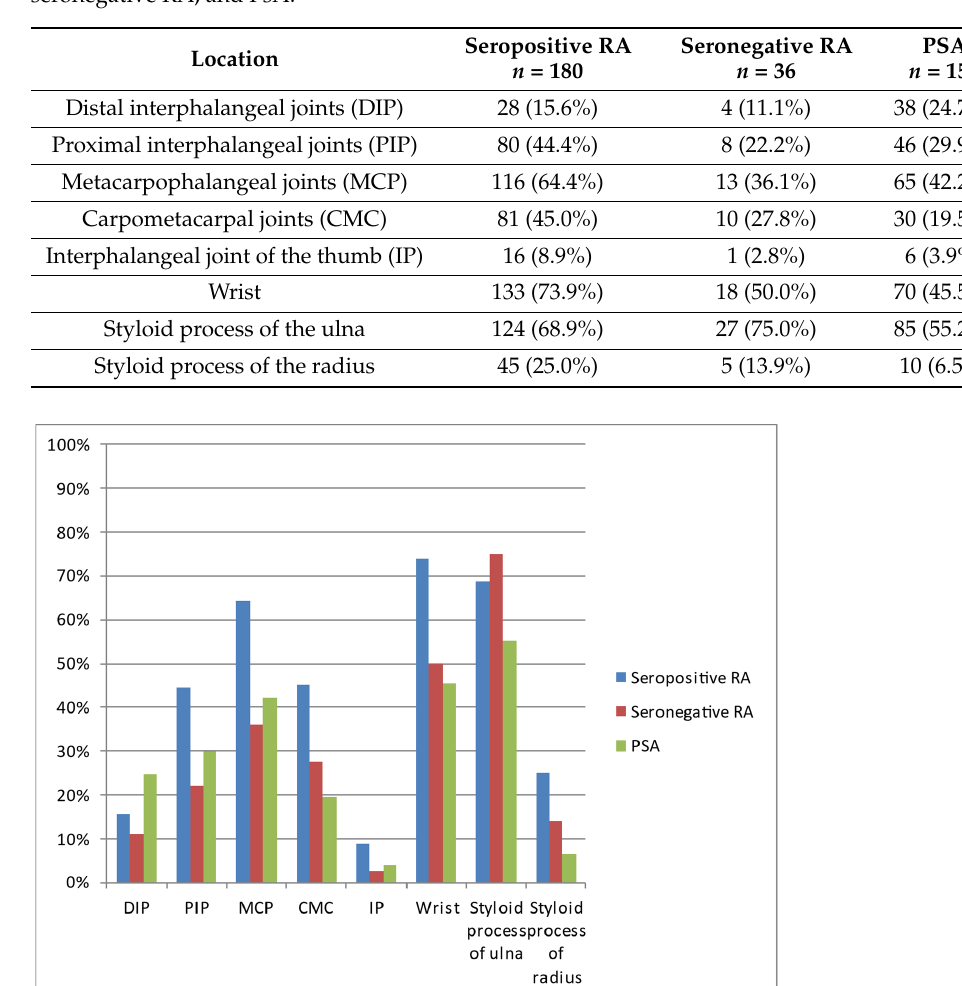
Table 3. Locations of lesions on hand radiographs of analyzed patients with seropositive RA, seronegative RA, and PsA.